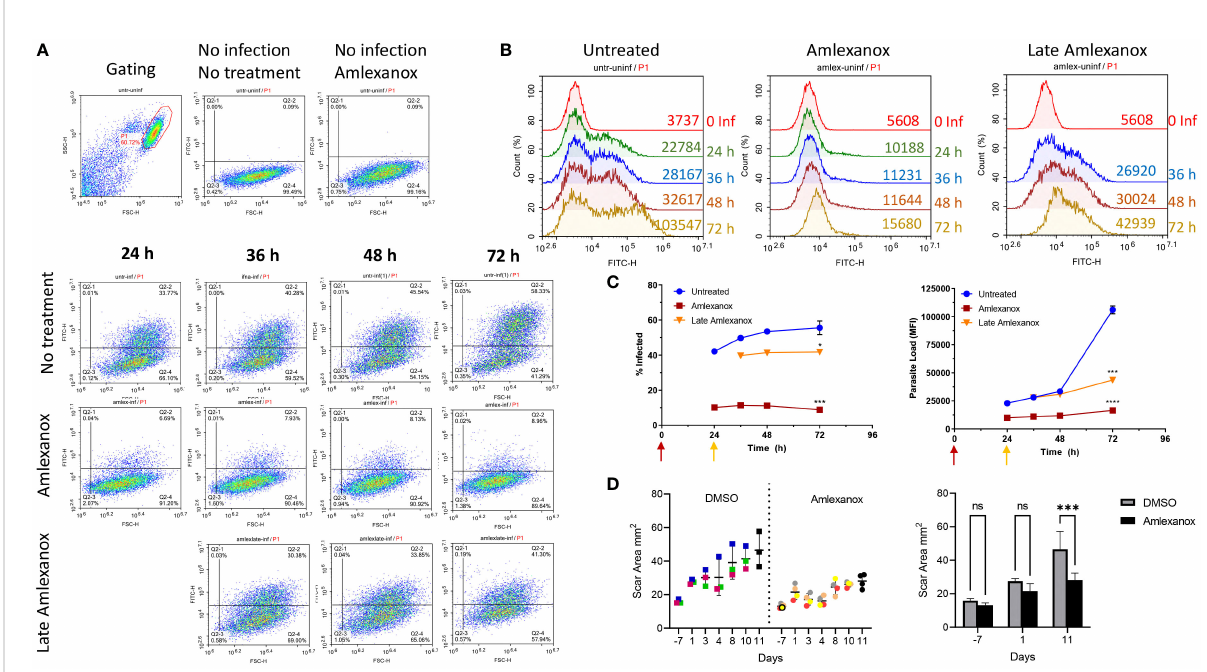
FIGURE 5 Amlexanox-induced inhibition of L. major infection in WT THP1 cells in a 3-day infection model. Differentiated THP-1 cells were infected with eGFP expressing L. major parasites at a MOI of 1:10 (macrophage:parasite). Infection percentages and parasite loads were quanti fi ed using a fl ow cytometer at the indicated time points. Amlexanox was added either 1 hour prior to infection or 24 h post infection (late amlexanox). (A) and (B) show representative fl ow cytometry density and histogram plots, corresponding to infected cell percent and parasite load, respectively. (C) Data presented in graphs are representative of two independent experiments with similar results Amlexanox was added at different time points in treated groups (purple, 1 h pre-infection; red, 24 h post-infection). 72 h data were statistically compared to untreated group using one-way ANOVA followed by Bonferroni ’ s multiple comparison test. (D) Footpad swelling in L. major infected mice treated or not with amlexanox starting on day 41 post-infection for or a duration of 12 days. Results were based on digital caliper measurement of footpad depth and width of DMSO injected controls (n=3) and amlexanox injected (n=4) treatment group. Data were statistically compared using multiple unpaired t tests. ns, not signi fi cant, *p ≤ 0.05, ***p ≤ 0.001, ****p ≤